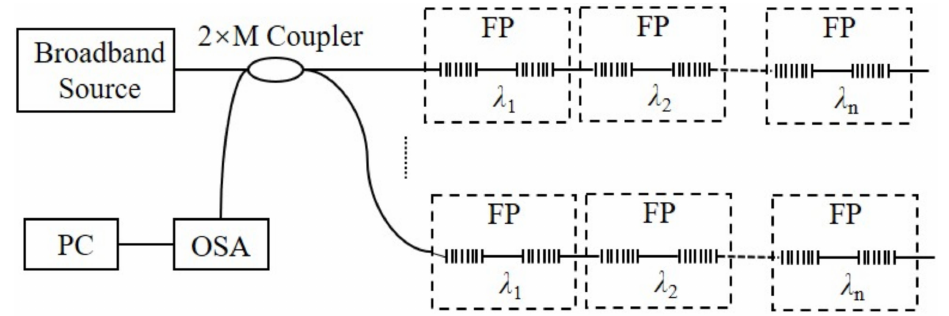
Figure 12. CFBG-FP sensor multiplexing technology: